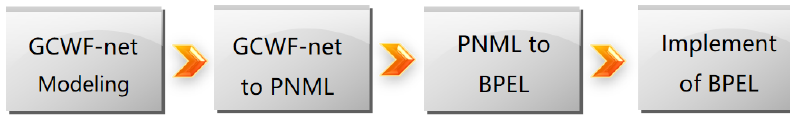
Figure 3. Implement process of